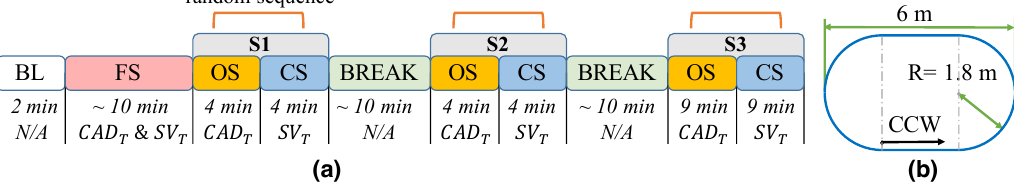
Figure 5. ( a ) Experimental protocol. The sequence of the two rhythmic stimuli (OS = open-loop vibrotactile stimuli, CS = closed-loop vibrotactile stimuli) was randomized. The stimuli in OS mode were triggered at a constant pace corresponding to a target cadence CAD T , while the stimuli in CS mode were modulated by the PI controller, given a target velocity SV T ; ( b ) For all the tasks, participants were instructed to walk counter-clockwise along a prescribed oval path marked on the floor. BL,